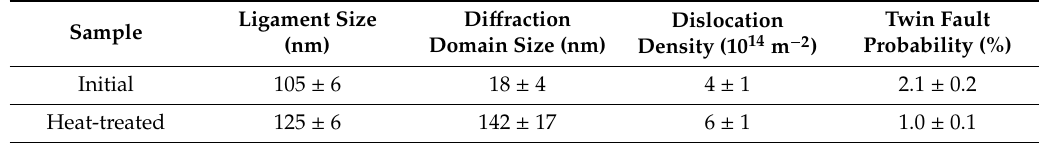
Table 2. Mean ligament size determined by SEM, along with average di ff raction domain size, dislocation density, and twin fault probability obtained by X-ray line profile analysis (XLPA) for initial foam and heat-treated sample.